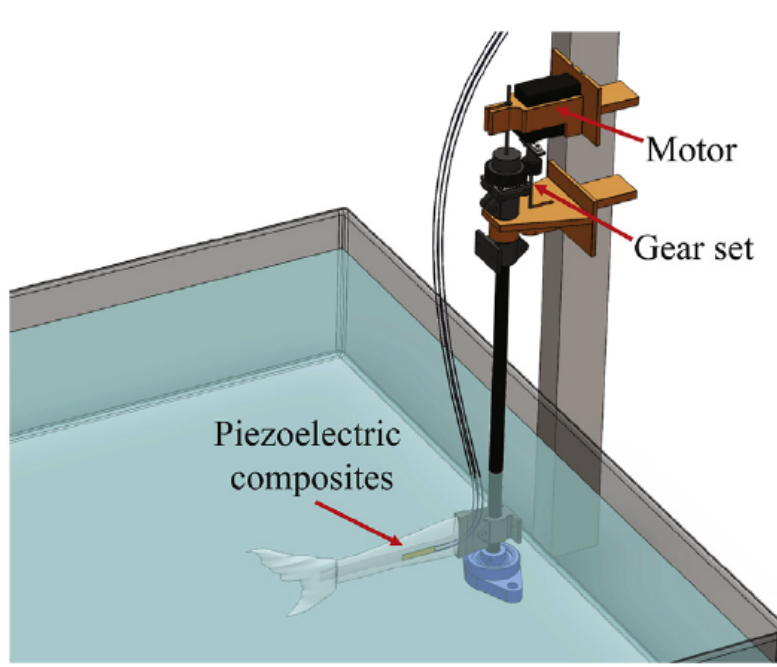
Figure 10. Energy Harvesting in a biomimetic fish [116].